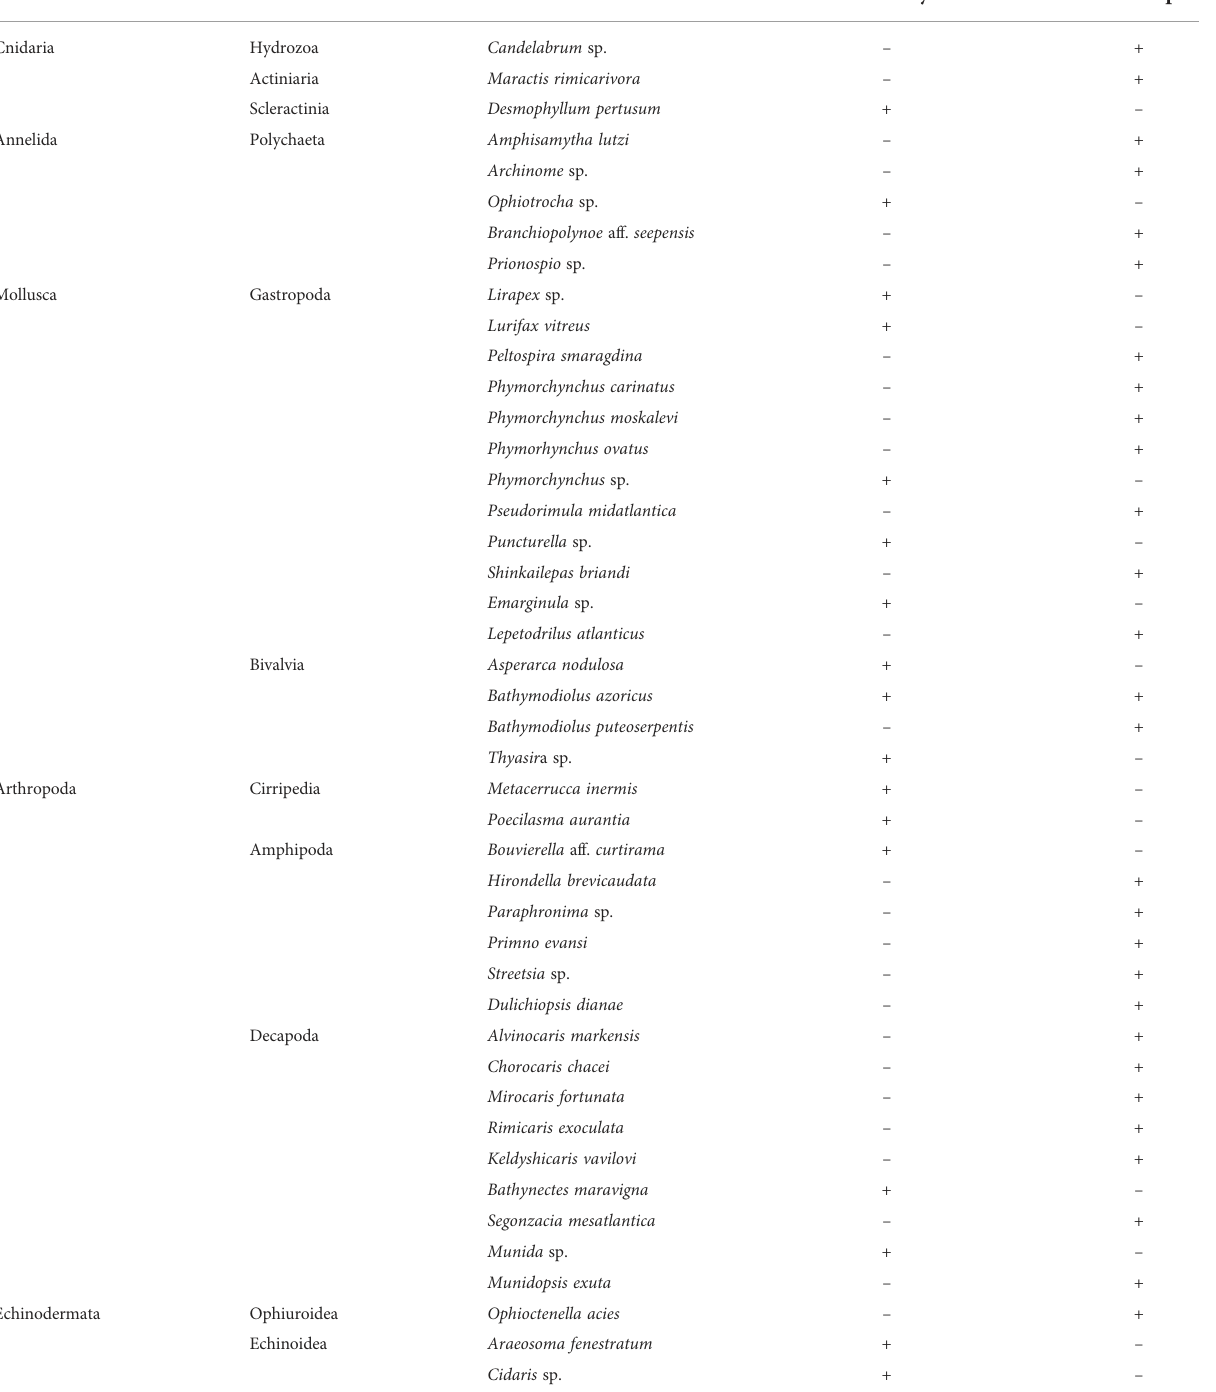
TABLE 3 Non-meiofaunal taxa reported from the PECA vent fi elds (Lost City and Broken Spur) (data from Copley et al., 1997; Kelley et al., 2005; Gebruk and Mironov, 2006; Vereshchaka and Vinogradov, 2006; Boschen-Rose and Colac ̧ o, 2021); +, taxon recorded; -, taxon not recorded.